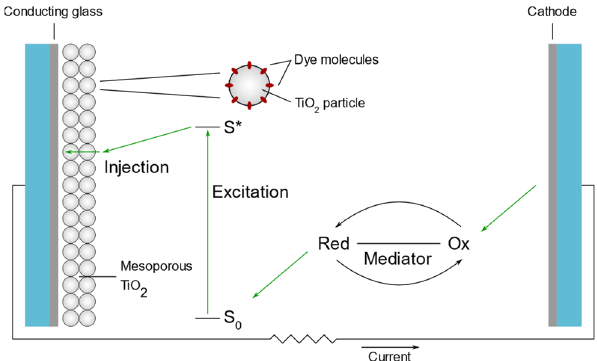
Figure 1. Simplified scheme and working principle of a DSSC.